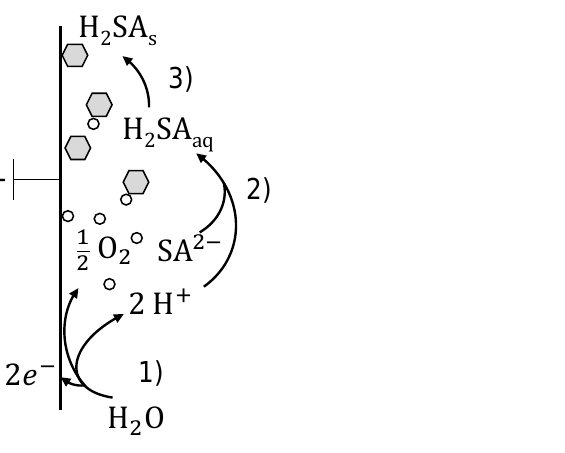
Figure 1. Nucleation in the vicinity of the anode due to an electrochemically induced acidification of the solution separated in three steps: (1) water splitting reaction, (2) protonation of the succinic acid and (3) nucleation of protonated succinic